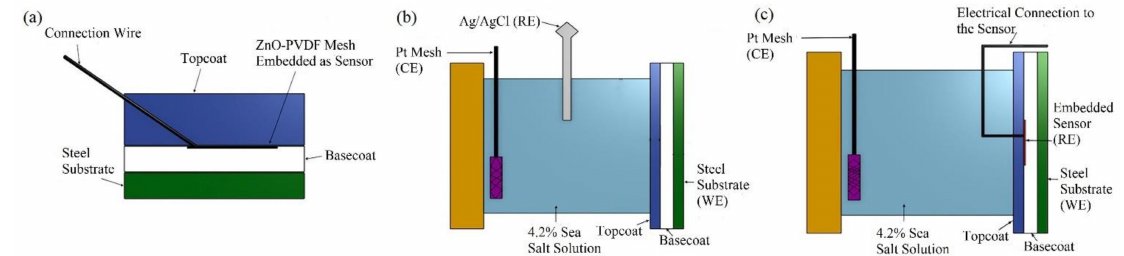
Figure 1. Schematic diagram of coated sample and electrochemical impedance spectroscopy (EIS)